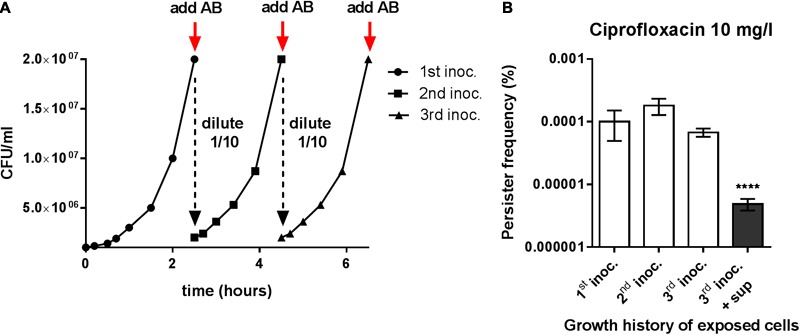
Persister reducing activity is unrelated to the stationary phase inoculum. (A) Setup of the re-inoculation experiment to assay for true type II persisters. The initial culture (1st inoc.) was generated by a 1000-fold dilution of stationary phase cells in fresh TSB followed by growth for 2.5 h to enter exponential growth and reach a cell density of approximately 2 × 107 CFU/ml. The subsequent cultures (2nd and 3rd inoc.) were derived from the initial culture by successive back-dilution (1/10) in fresh TSB and growth until reaching the same cell density. (B) Persister frequencies obtained after challenging the different S. aureus strain Newman cultures with 20x MIC of ciprofloxacin. The third culture was grown in the presence or absence of 25% stationary phase endogenous supernatant. The data represent the mean persister frequencies ± SD calculated from three biological replicates (∗∗∗∗P < 0.0001).